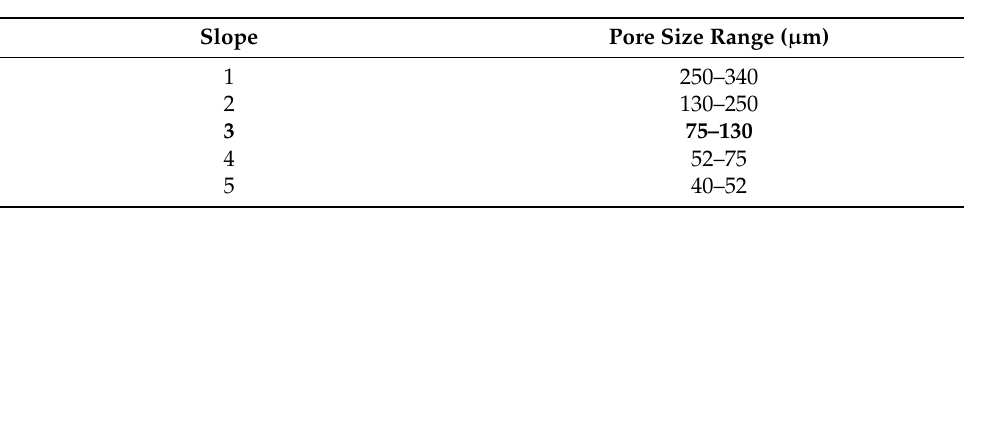
Figure 7. Cumulative volume intrusion curves for three specimens of sample ( a ) A with 0% 0.125 ( b ) B with 20% 0.125. ( c ) C with 40% 0.125. Table 3. Pore size range of the 9 molding material